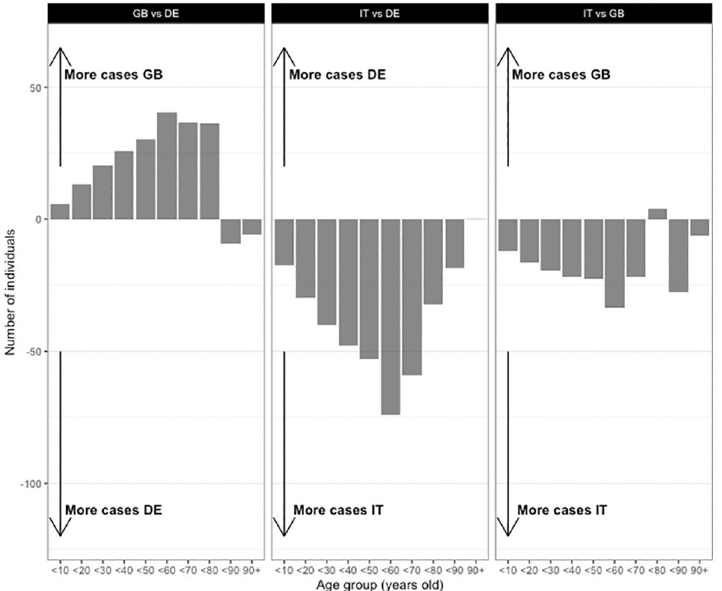
Fig 5. Effects of degree distribution on the average number of infected individuals across age groups. Dyadic contagion probability p = 0.05. Differences in the average number of infected individuals across 10-year age groups at the end of the simulation runs, attributable to differences in degree distribution only . All networks have the population age structure and the age mix of Italy. Left panel compares Great Britain with Germany; central panel Germany with Italy; right panel Great Britain with Italy. The x-axis represents equality: both networks have the same number of infected individuals.